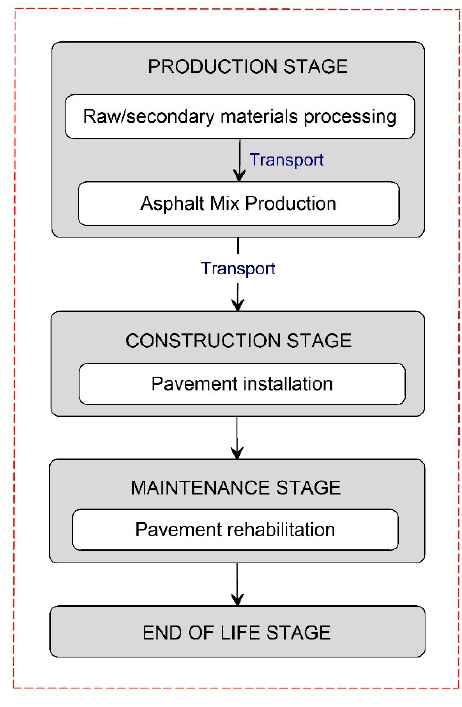
Figure 3. System boundaries.